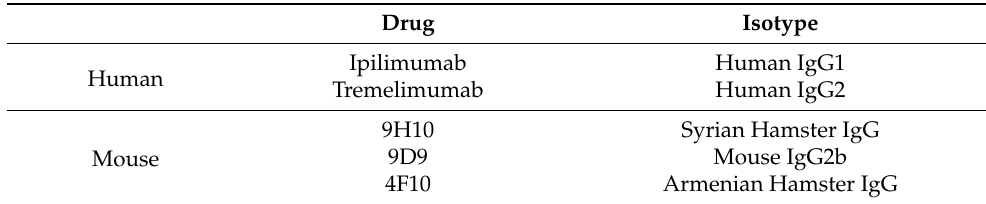
Table 1. Summary of common anti-CTLA-4